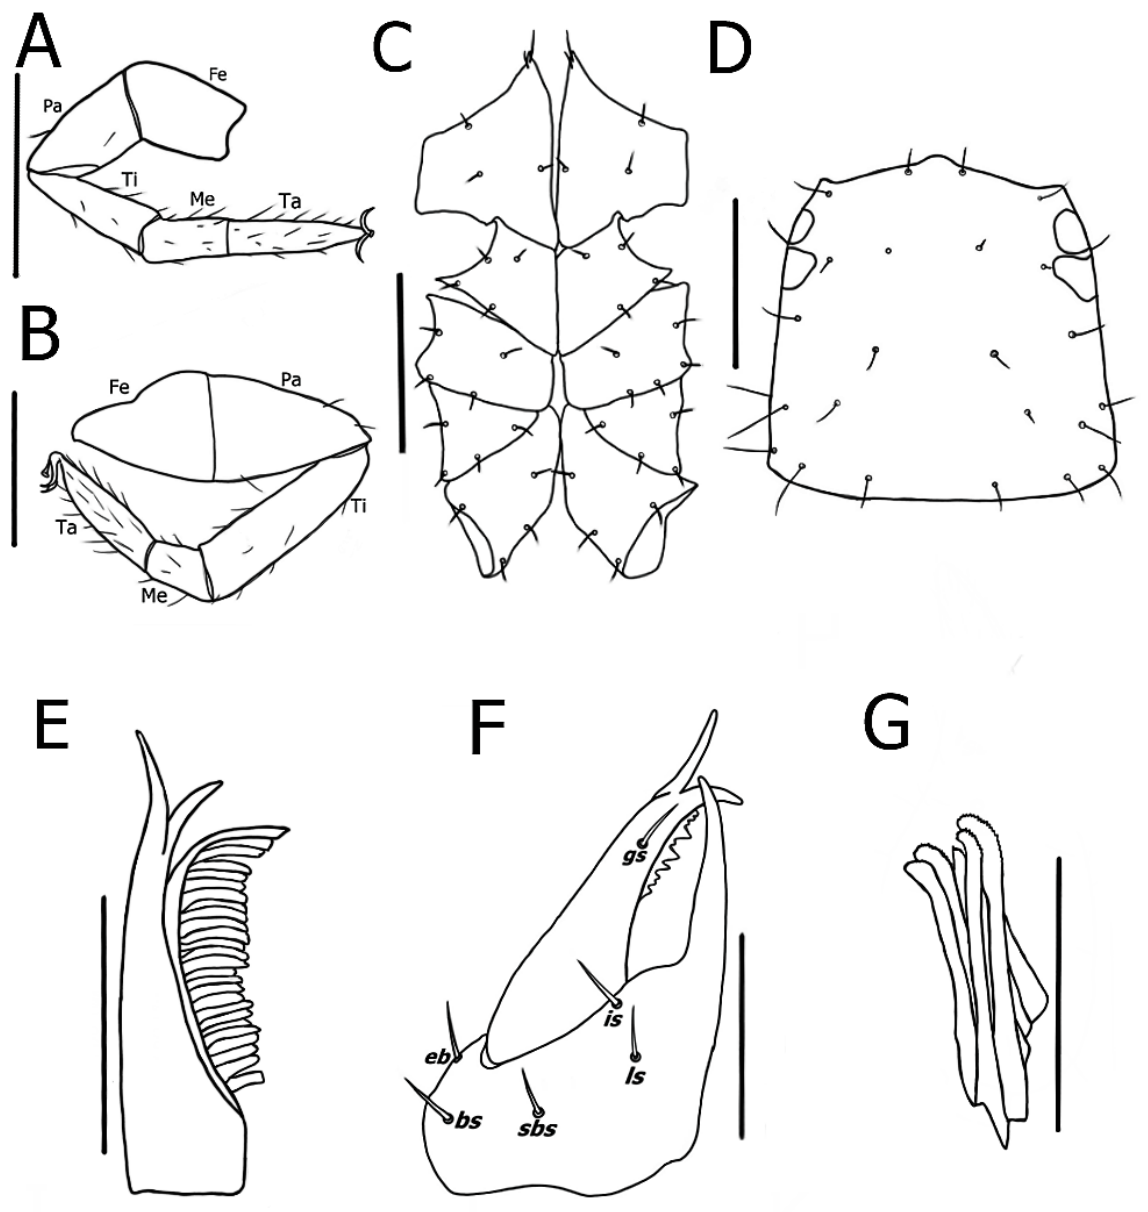
Fig. 17. Ideobisium susanae sp. nov. A . Leg I. B . Leg IV. C . Coxa. D . Carapace. E . Serrula exterior. F . Chelicera in dorsal view, showing trichobothria. G . Rallum. A–D, F: holotype, ♀ (QCAZ); E, G: paratype, ♂ (ZMH A0003693). Abbreviations: Fe = femur; Pa = patella; Ti = tibia; Me = metatarsus; Ta = tarsus. Scale bars: A–D = 0.25 mm; E = 100 µm; F = 0.125 mm; G = 40